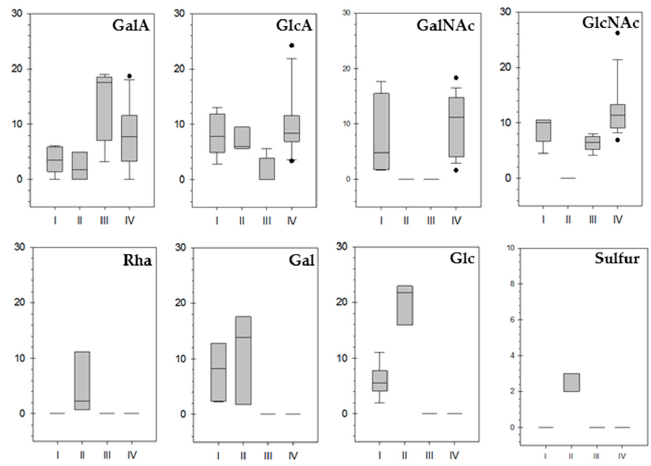
Figure 3. Box plot representation of the EPS chemical composition as a function of HCA clusters. In the boxes, the 25 th , 50 th and 75 th percentiles are indicated by the bottom, middle and top lines, respectively. Whiskers show the 10 th and 90 th percentiles. Individual dots are the outliers.